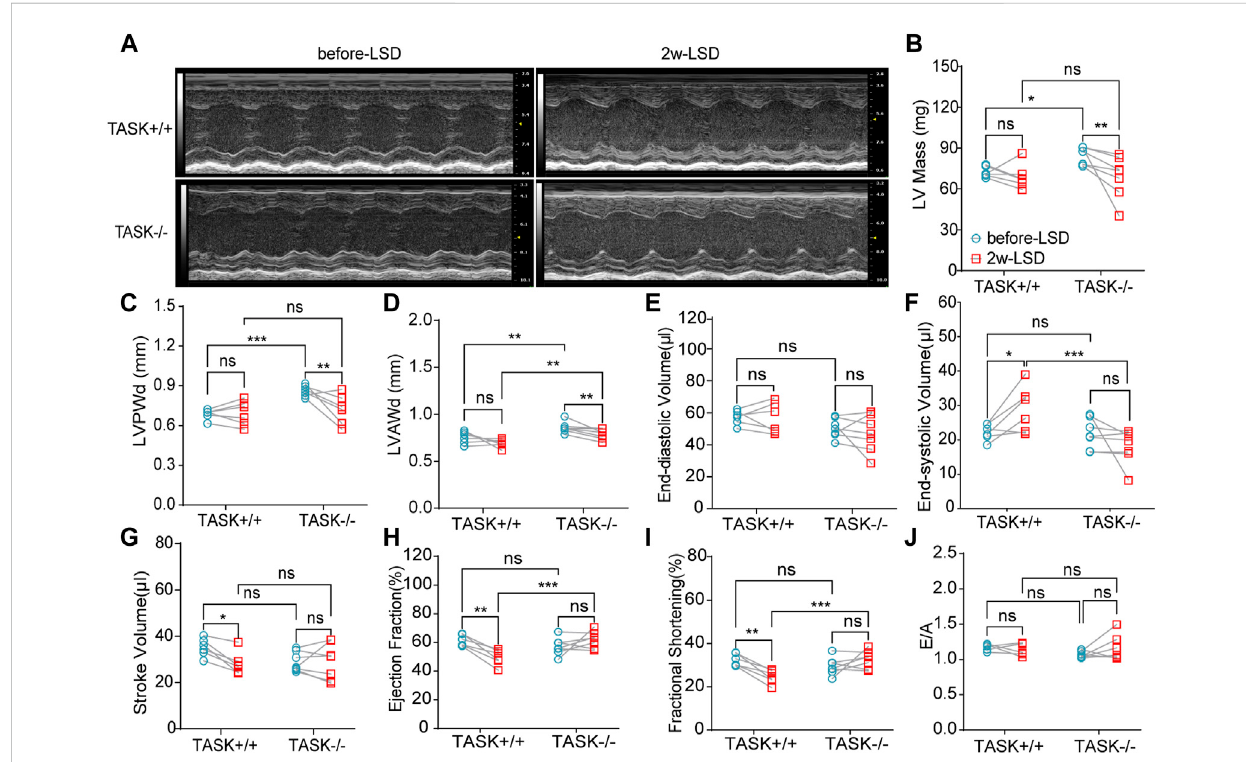
FIGURE 2 LSD alleviates LV wall thickness in TASK − / − mice. Representative M-mode echocardiogram images of the LV from TASK +/+ and TASK − / − mice before andafteratwo-weekLSD (A) .QuantitativecomparisonofechocardiographicparametersincludingLVmass (B) ,LVAWd (C) ,LVPWd (D) ,LVEDV (E) ,LVESV (F) ,strokevolume (G) ,ejectionfraction (H) ,fractionalshortening (I) andE/A (J) fromTASK +/+ andTASK − / − micebeforeand2 weeksafterLSD.Thesymbol* indicatesasigni fi cantdifferencebetweenTASK +/+ andTASK − / − usingunpaired t -tests,* p < 0.05,**** p < 0.0001.Thesymbol#indicatesasigni fi cant difference between before and after 2 weeks of LSD based on paired t -tests, # p < 0.05, ## p <